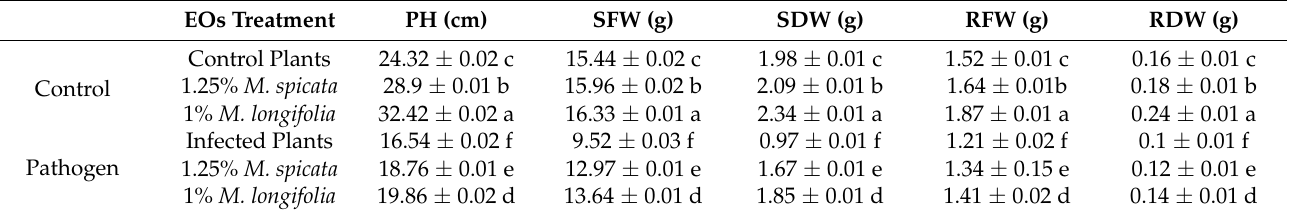
Table 3. Effects of M. spicata and M. longifolia EOs on L. esculentum seedling growth under Fusarium root rot disease infection.